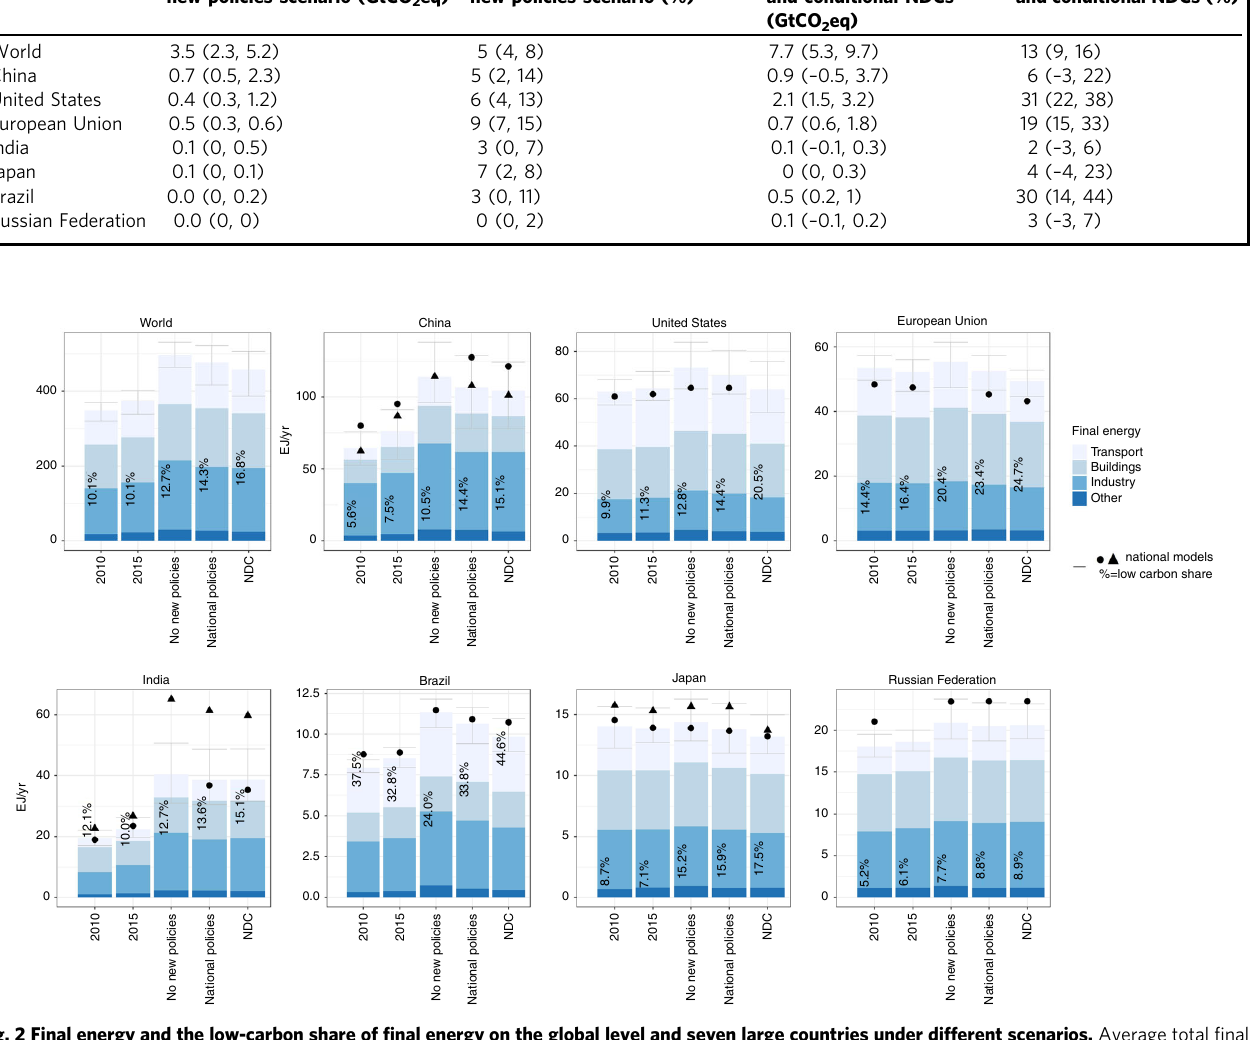
Fig. 2 Final energy and the low-carbon share of fi nal energy on the global level and seven large countries under different scenarios. Average total fi nal energy for 2010, 2015 and 2030 of nine global integrated assessment models is subdivided into sectors: transport, buildings, industry and other. Total fi nal energy includes the 10th to 90th percentile ranges for total fi nal energy (error bars). The black dots/triangles indicate fi nal energy based on national model estimates (China-TIMES and IPAC for China, GCAM-USA for the United States, PRIMES for the European Union, AIM India and India MARKAL for India, RU-TIMES for the Russian Federation, BLUES for Brazil and AIM/Enduse and DNE21 + for Japan). The data is available in the source